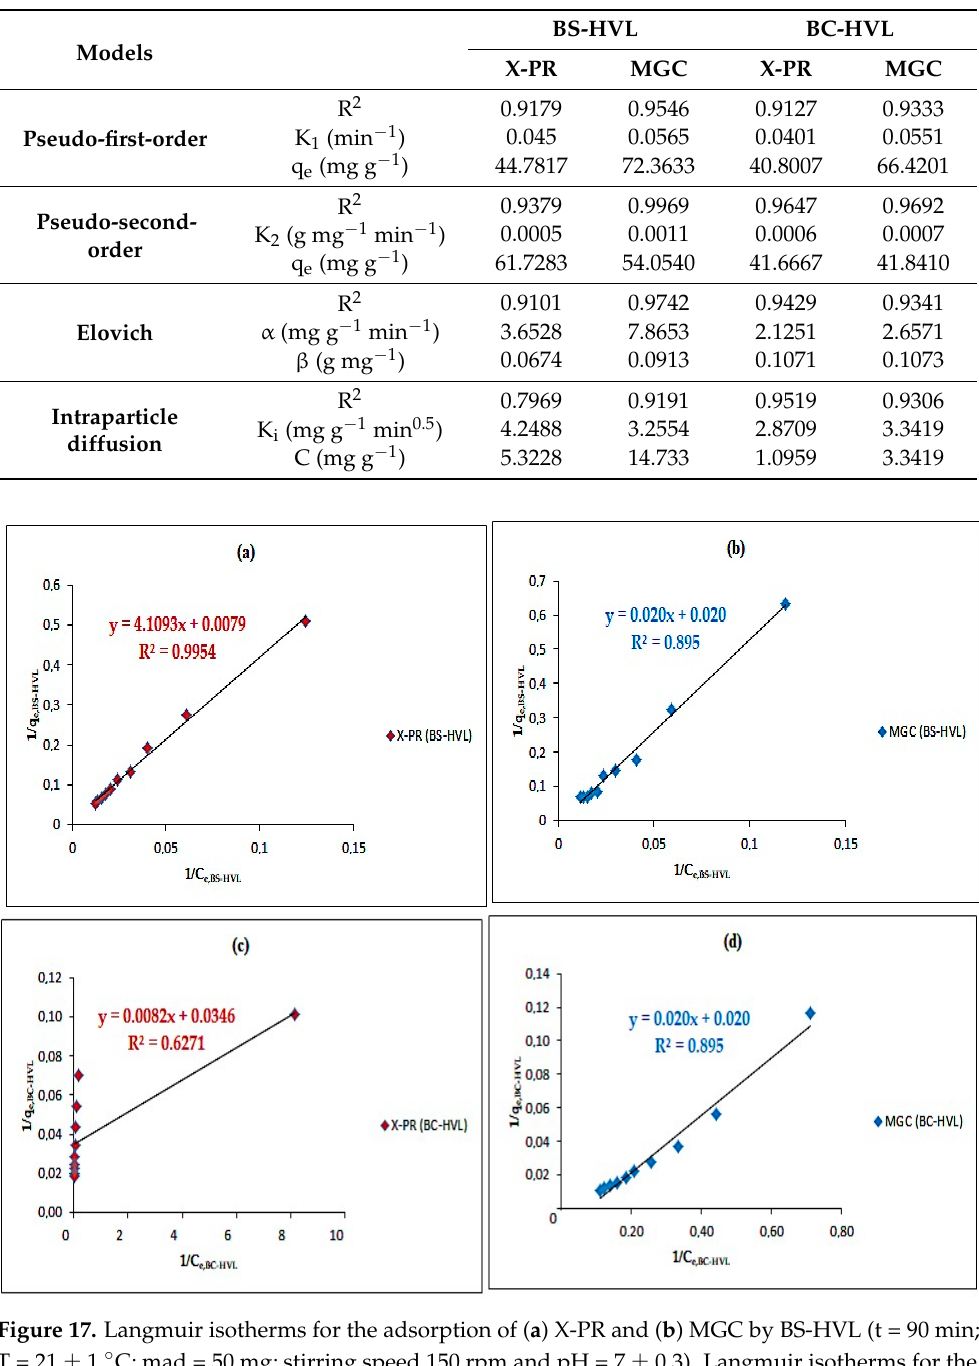
Table 1. Adsorption kinetic constants of X-PR and MGC by BS-HVL (T = 21 ± 1 ◦ C; m ad = 50 mg;